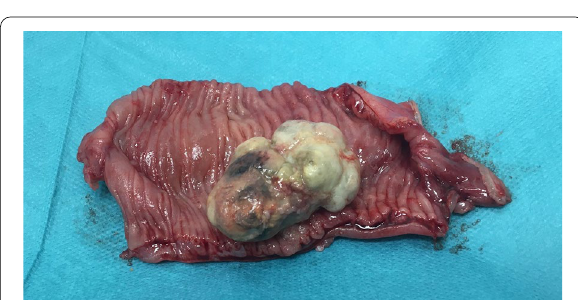
Fig. 3 Resected specimen. The tumor originated from the mucosa of the ileum. The surface is whitish to grayish with erosion and inflammatory